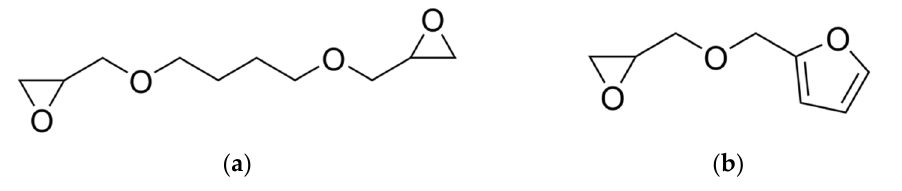
Figure 1. Chemical structures of epoxy diluents BD ( a ) and FUR ( b ).